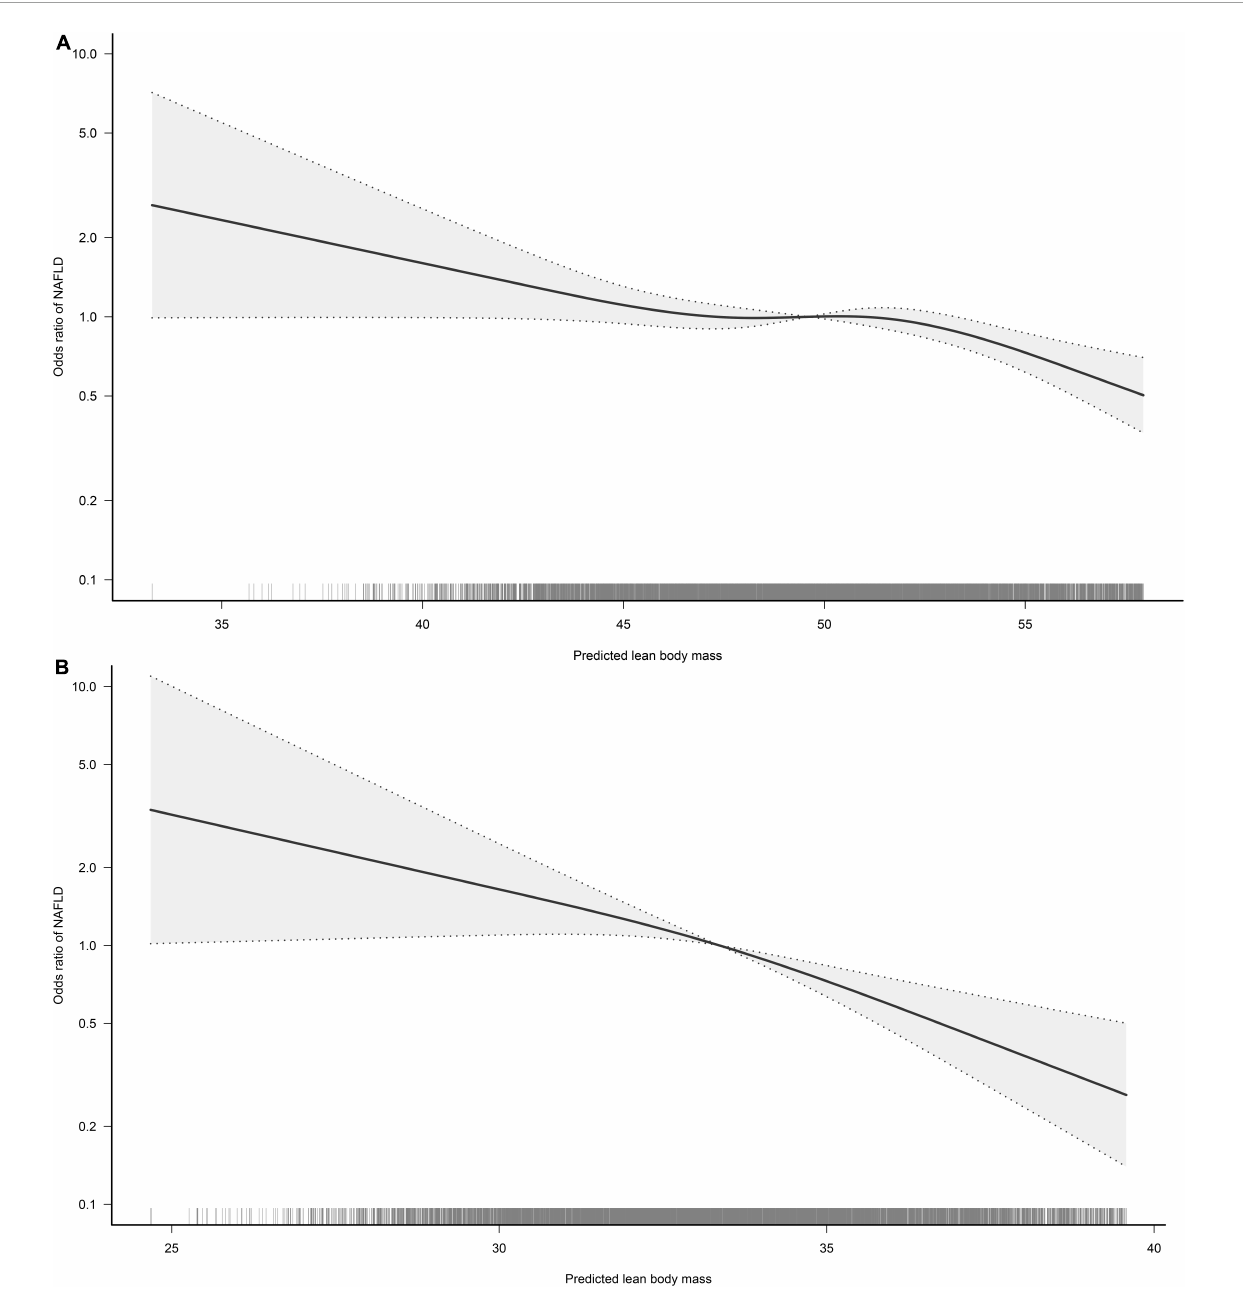
FIGURE2 Restricted cubic spline analysis of predicted lean body mass (LBM) for the estimation of the risk of non-alcoholic fatty liver disease (NAFLD) in men (A) and women (B) . Adjusted for age, exercise habits, drinking status, smoking status, ALT, AST, GGT, FPG, HbA1c, TC, TG, HDL-C, and